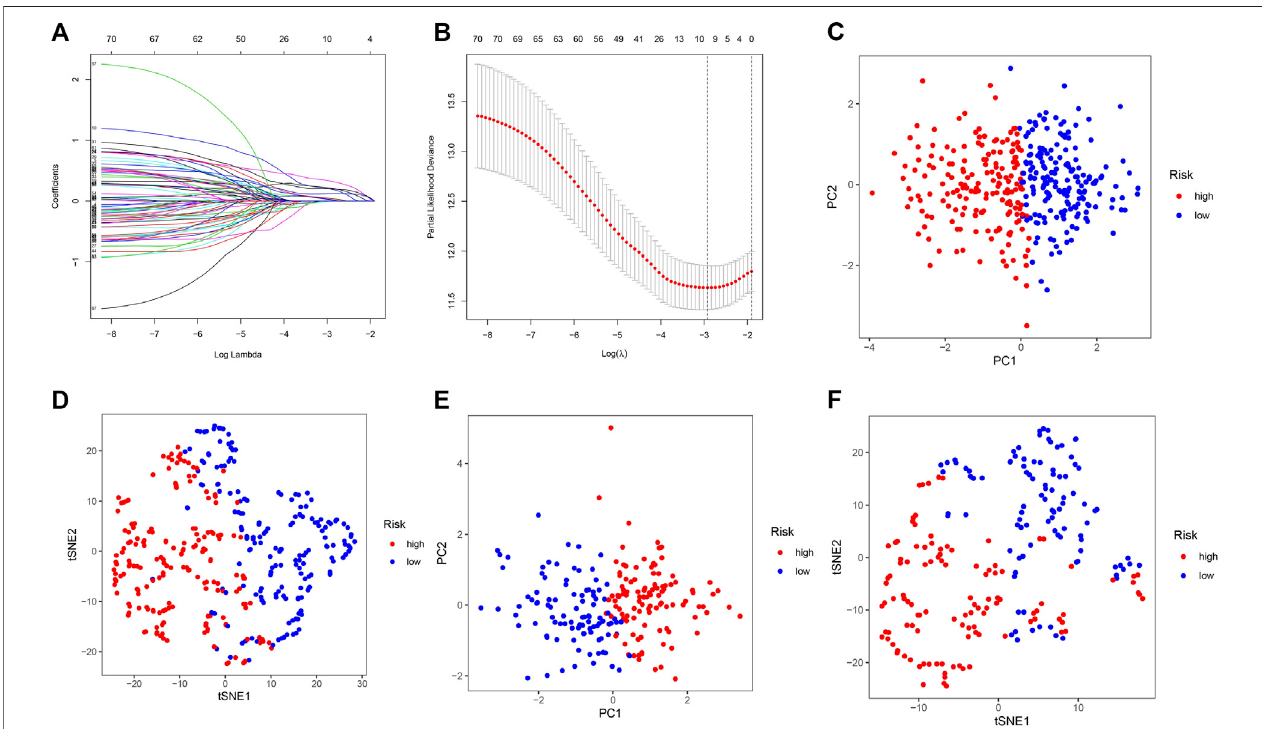
FIGURE3| Construction and validationofthecancer drivergenessignature intheTCGA and ICGC cohort. (A – B) Lasso regressionscreens candidate riskcancer driver genes. (C) PCA validation of the distribution of different risk groups in the training set. (D) T-SNE validation of the distribution of different risk groups in the training set. (E) PCA validation of the distribution of different risk groups in the ICGC set. (F) T-SNE validation of the distribution of different risk groups in the ICGC set.